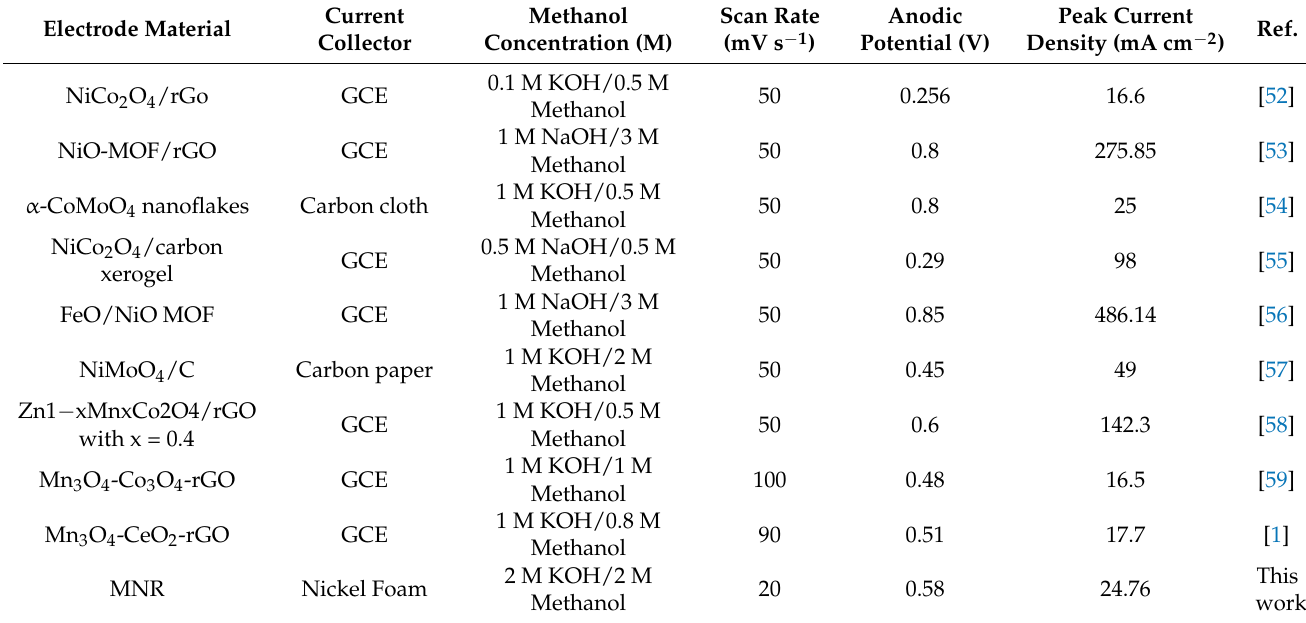
Table 1. Comparison of electrochemical properties of MNR in MOR with some reported